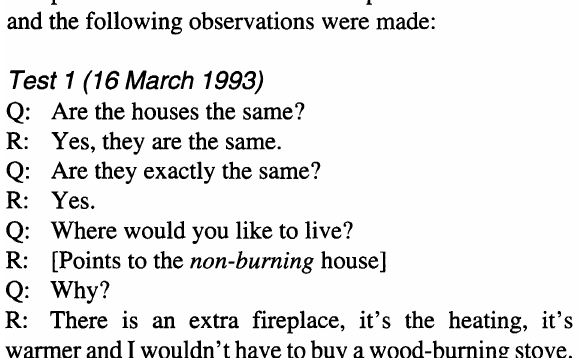
Halligan, 1993), he omitted the upper part of the left branch. On two visual search tasks (involving either objects or numbers) he needed substantially more time to locate targets placed on the left than the right side of the page (mean time for locating objects: right side 1.2 s; left 24 s; for numbers: right side 2.5 s; left 16 s-total number of trials